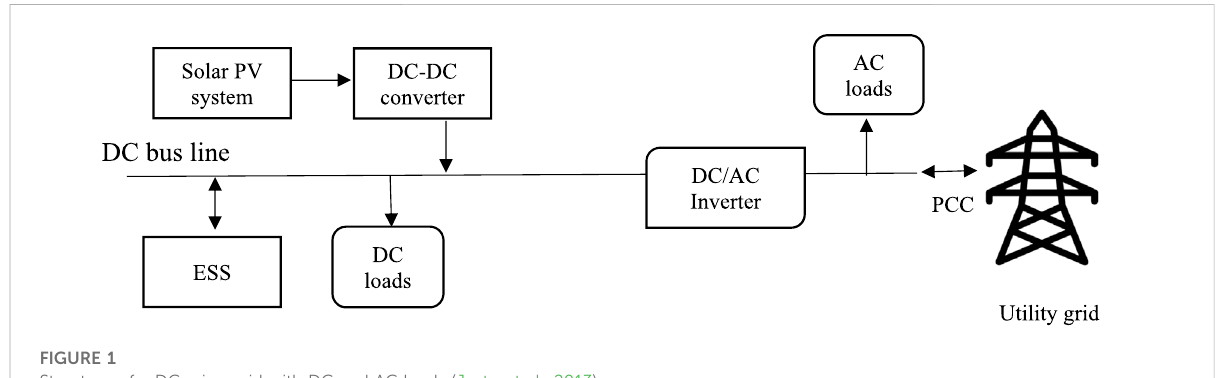
FIGURE 1 Structure of a DC microgrid with DC and AC loads (Justo et al.,